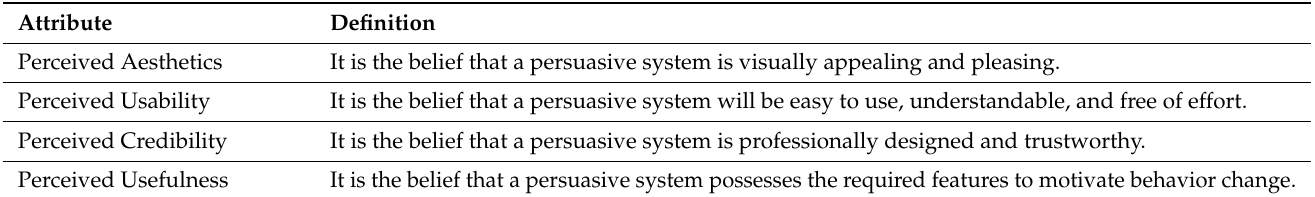
Table 1. UX design attributes and definition